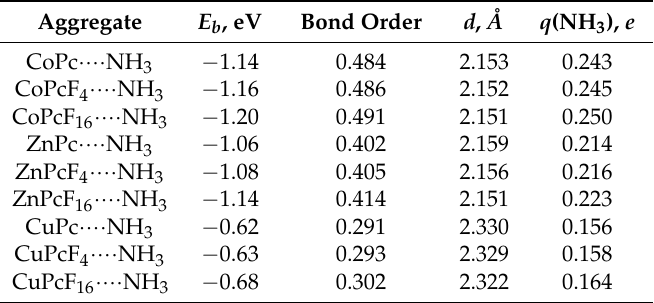
Table 2. Parameters of binding of NH 3 with MPc, MPcF 4 , and MPcF